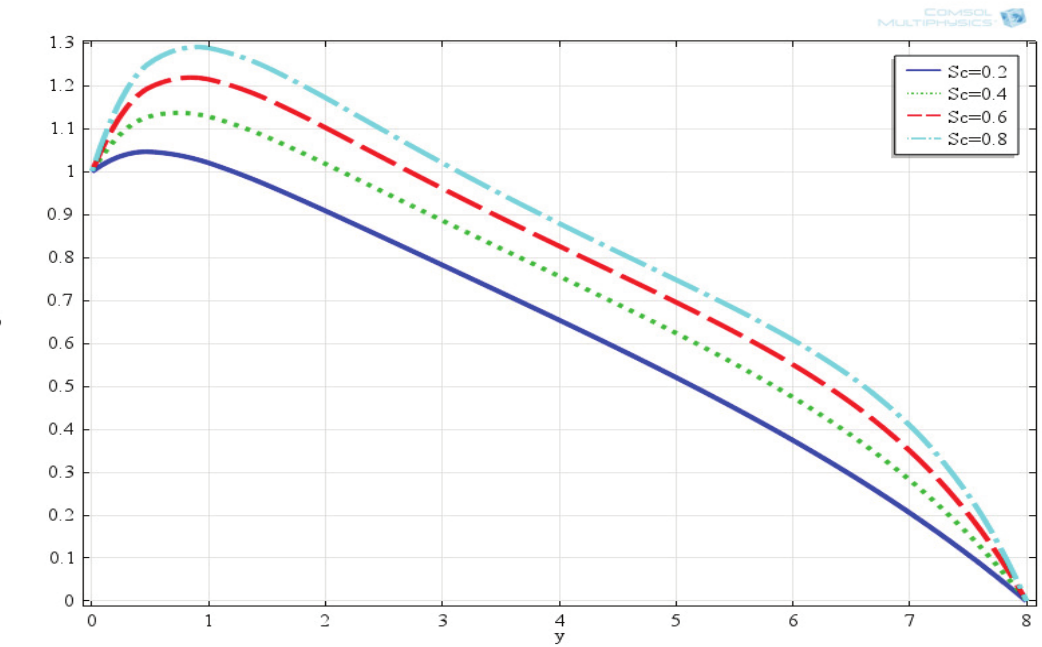
Figure 10: Steady state concentration profiles for different values of Sc at